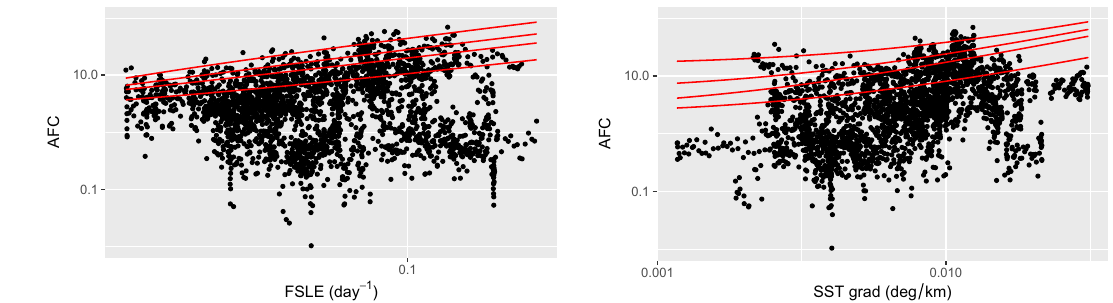
Figure 3. Scatter plot of AFC against FSLE (left panel) and SST gradient (right panel) for all the points sampled (thus not filtered based on chlorophyll). The lines, from the bottom to the top, indicate the linear quantile regressions at 75th, 90th, 95th and 99th percentiles. The analysis is used to investigate the relationship between the front intensity and just the higher values of fish concentration. Both axes are in logarithmic scale (values equal to zero are therefore not depicted). Values of the quantile regression coefficients are reported in Table S1.